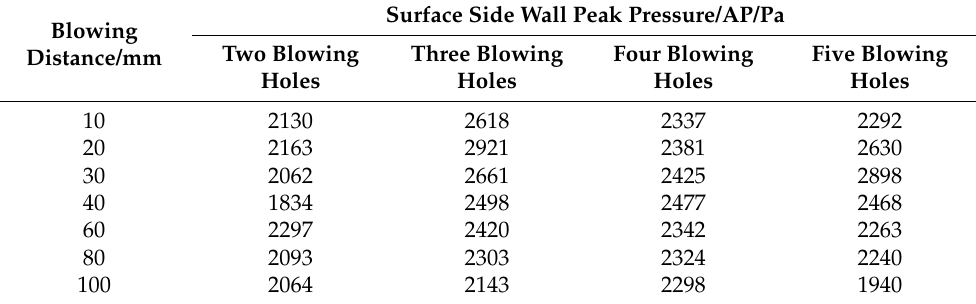
Table 4. Analysis of the average surface side wall peak pressure under different type of blowing hole with different blowing